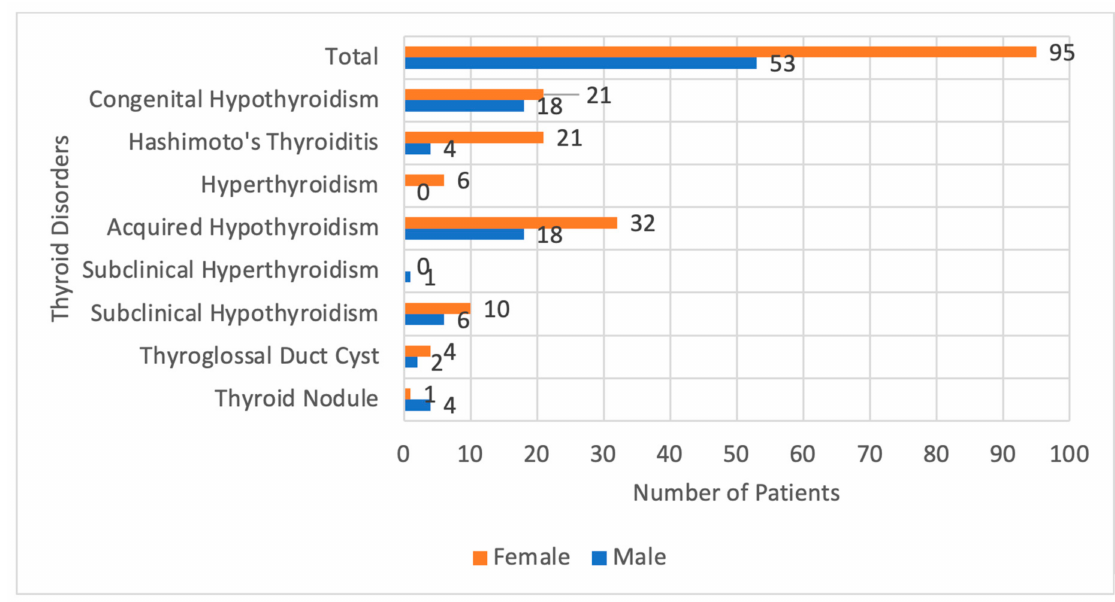
Figure 2. Gender Distribution of Each Specific Thyroid Disorders; showing female predominance in all thyroid disorders except thyroid nodules being commoner in males.